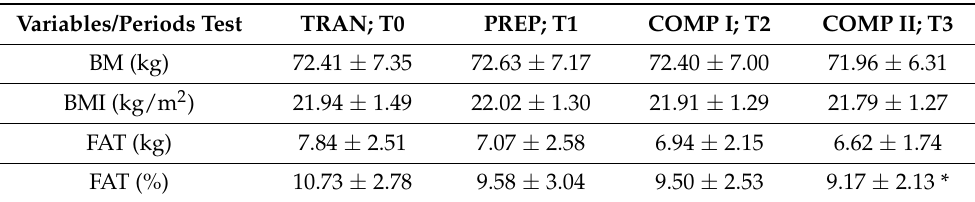
Table 1. Somatic and functional variables in the annual training cycle of cyclists. Data are presented as mean ± standard